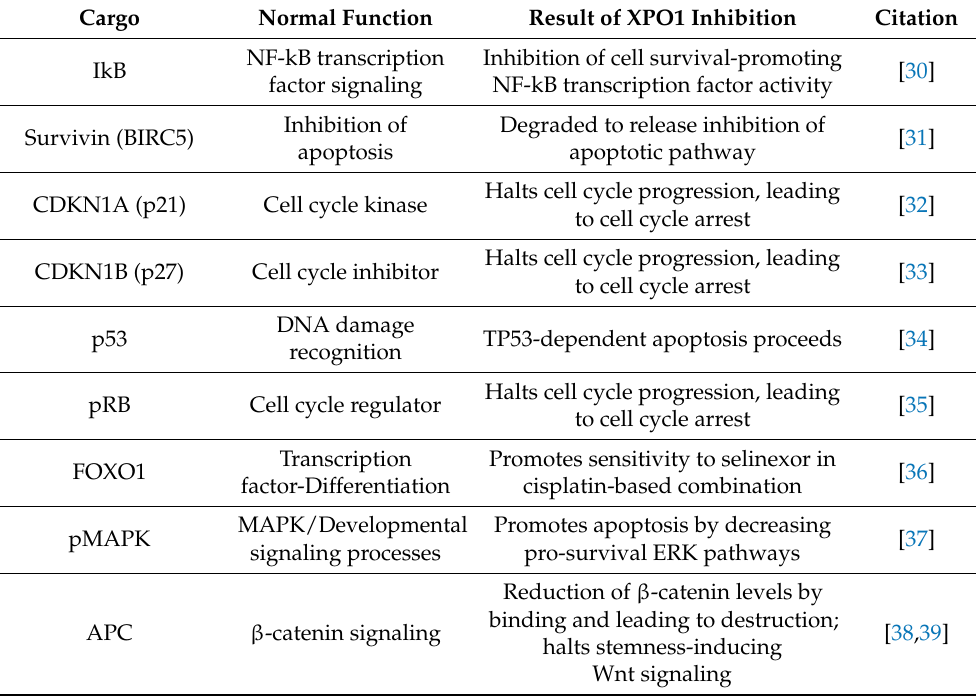
Table 1. Select XPO1 cargos implicated in childhood cancer